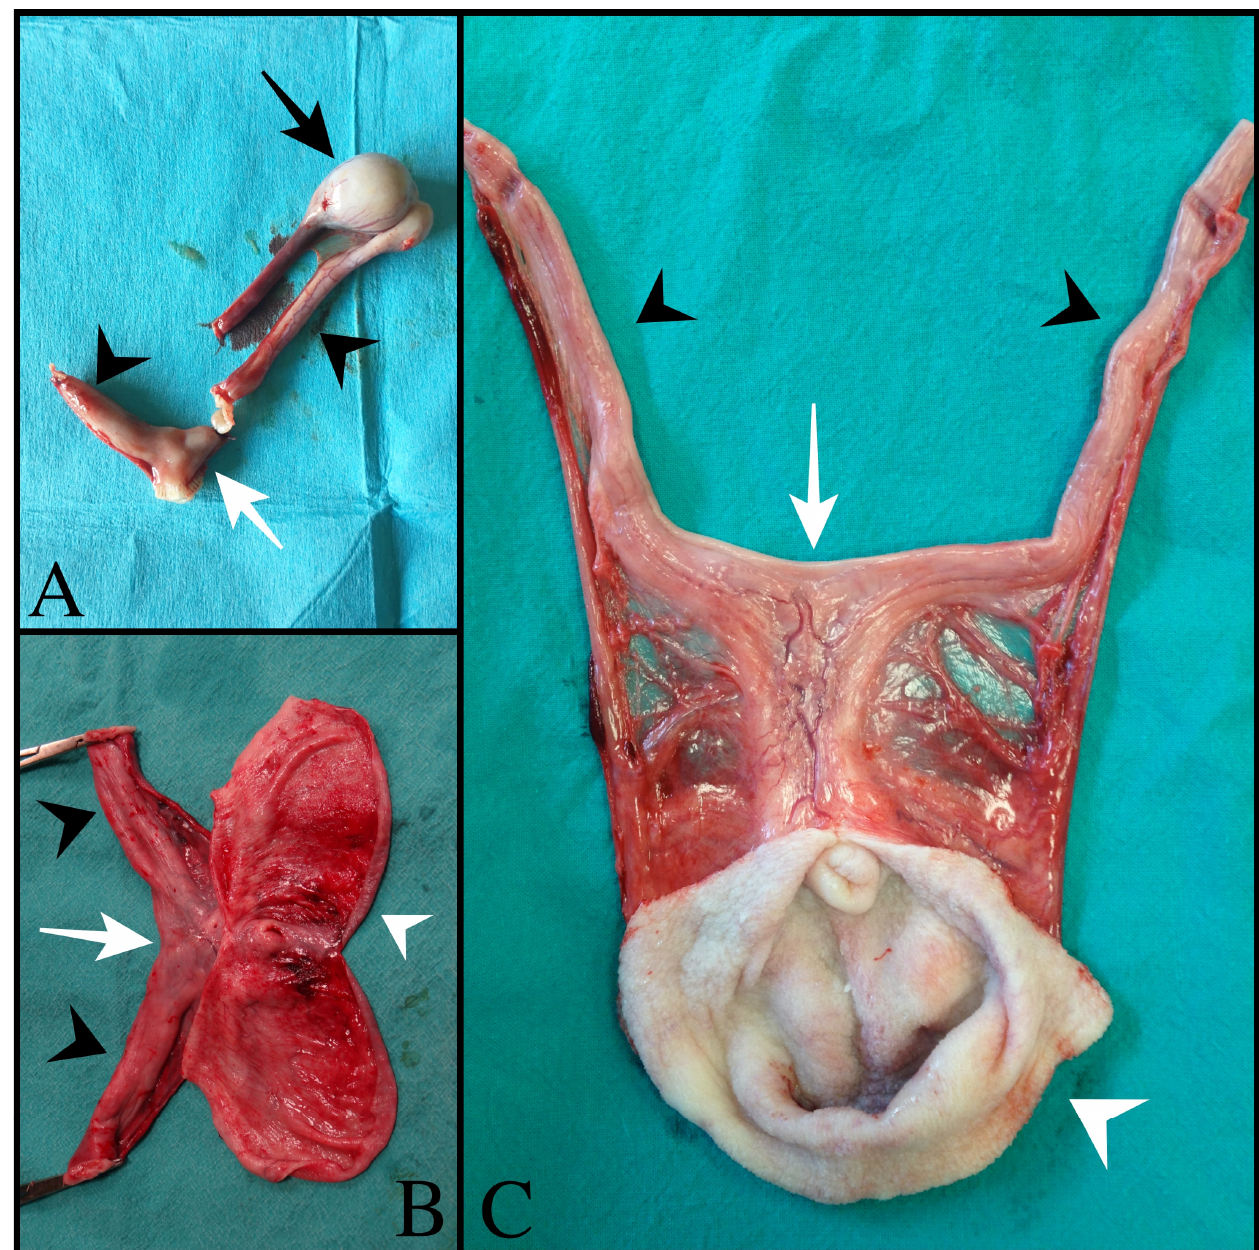
Figure 2. Gross anatomy of uterus masculinus : ( A ) Case number 1: The black arrow points to the normal testis. ( B ) Case number 2: White arrowhead points to the tubular fluid-filled structure originating from the dorso-cranial portion of the prostate gland. ( C ) Case number 3: White arrowhead points to the tubular fluid-filled structure originating from the dorso-cranial portion of the prostate gland. In all images, the black arrowhead points to the uterine horns, which arise from the body of the uterus masculinus (white arrow).